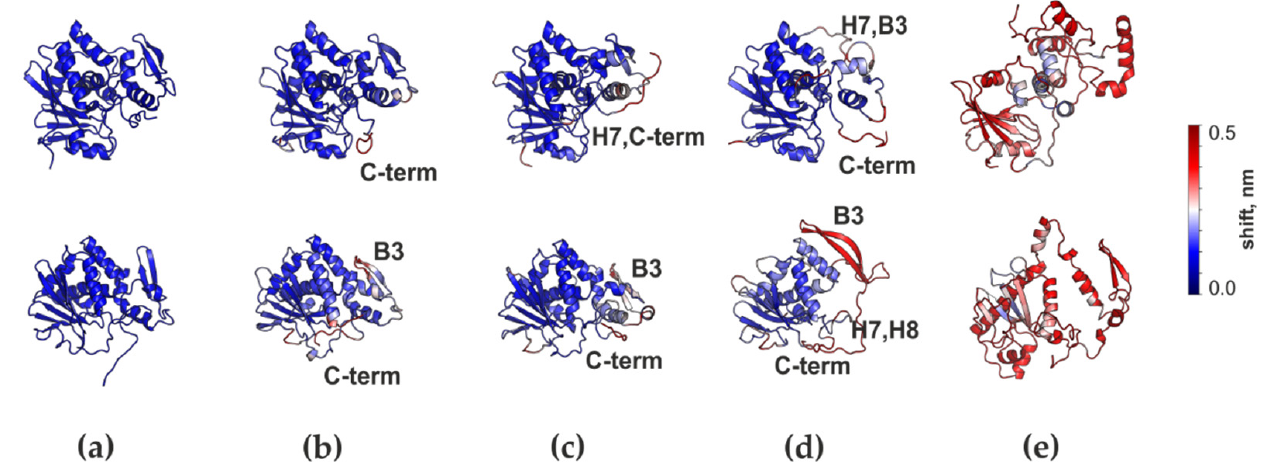
Figure 4. Solvent and temperature effects on the structure and dynamics of RTA and MLA as probed by MD simulations. Columns correspond to the structural-dynamic properties of the catalytic A subunits revealed by MD simulations of the full-length toxin heterodimers in water at 310 K ( a ) and of isolated catalytic A subunits in water at 310 K ( b ) and 340 K ( c ), urea/water ( d ), and chloroform/methanol ( e ) mixtures. The final spatial structures of RTA (top line) and MLA (bottom row) after each MD simulation are presented. The protein structural elements with high mobility are labeled and highlighted on the ribbon structures according to the maximal spatial deviation of the toxin backbone from the starting structure during MD simulation (color-coding in right). MD data for MLA were taken from [17].